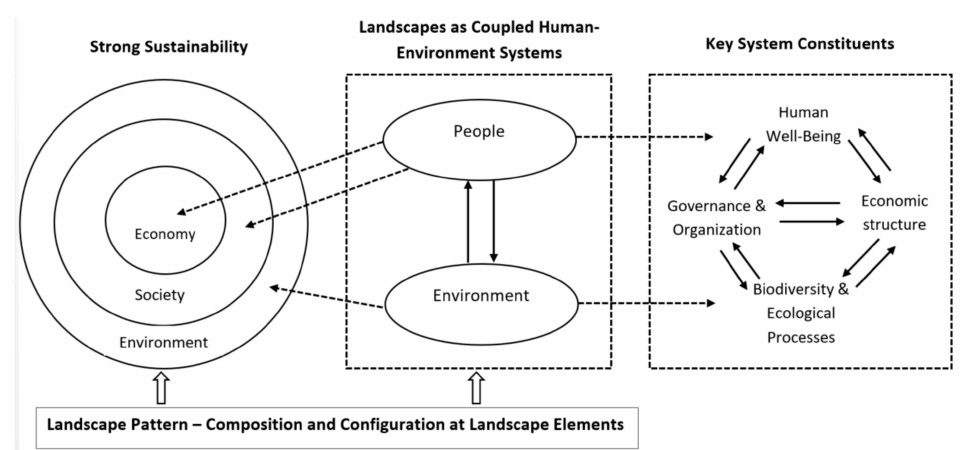
Figure 1. Theoretical framework for holistic sustainable landscapes (Modified from Wu,